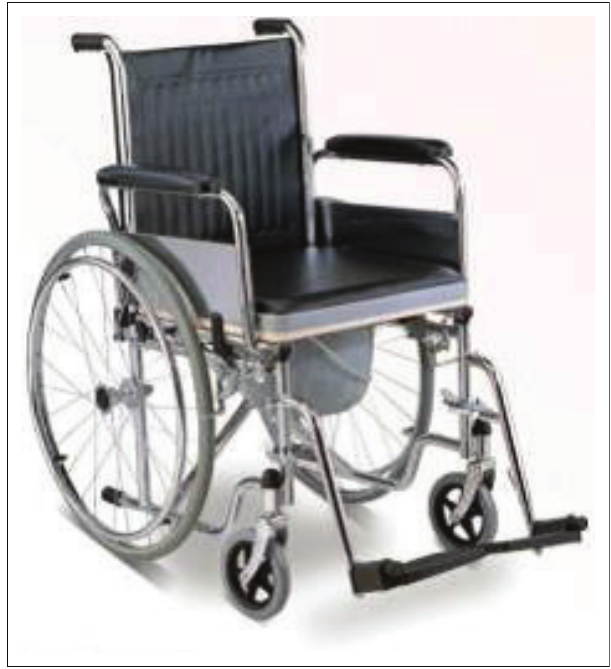
FIGURE 1: Hospital style